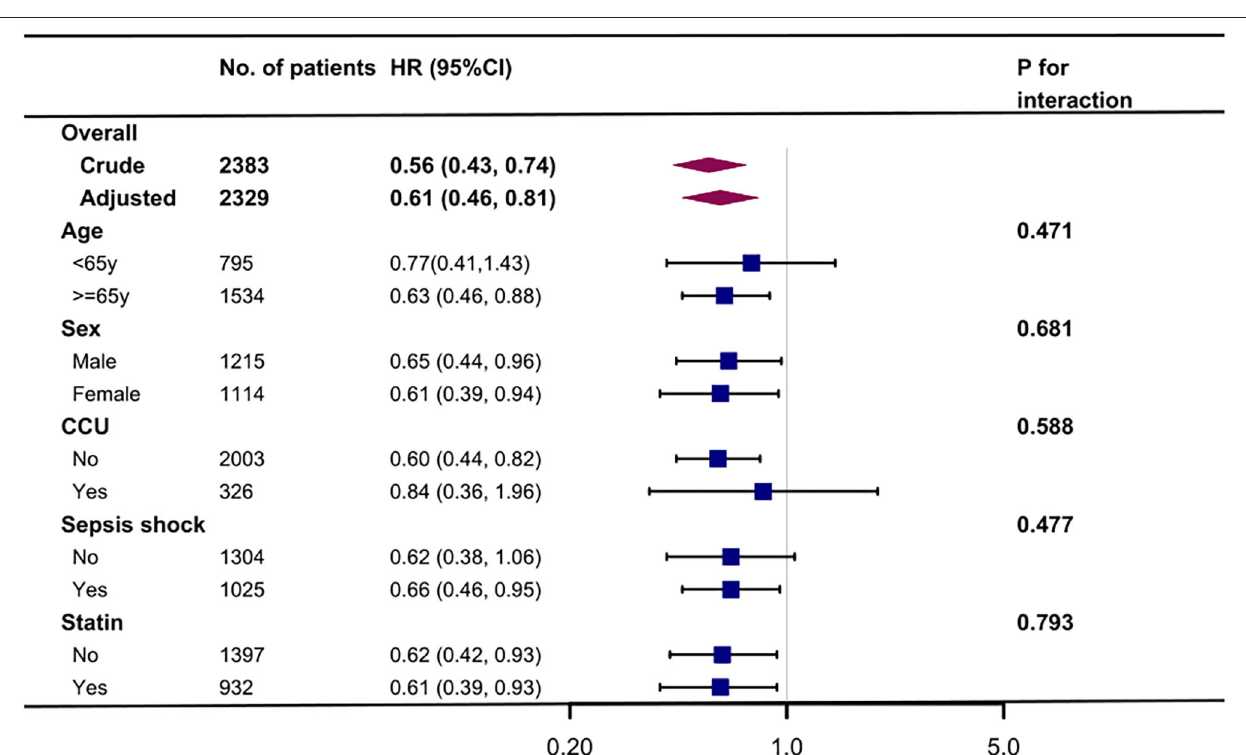
Frontiers in Medicine |